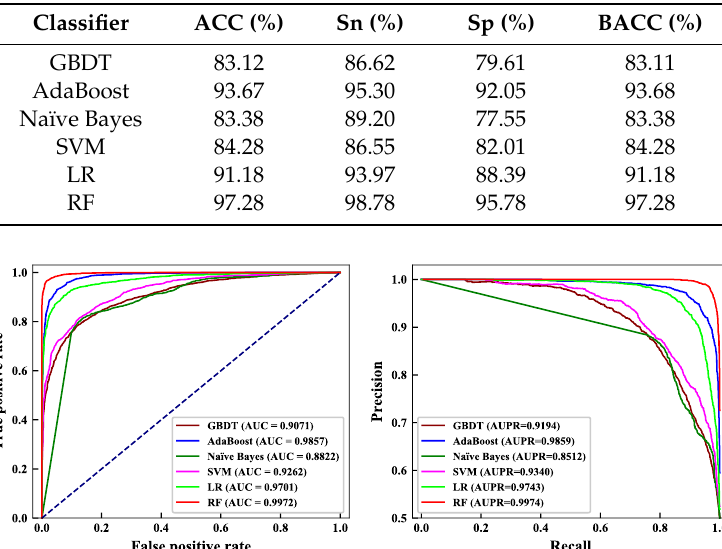
Figure 3. Comparison of ROC and PR curves of the six classifier algorithms. ( left ) ROC curve of the six classifier algorithms; ( right ) PR curve of the six classifier algorithms.